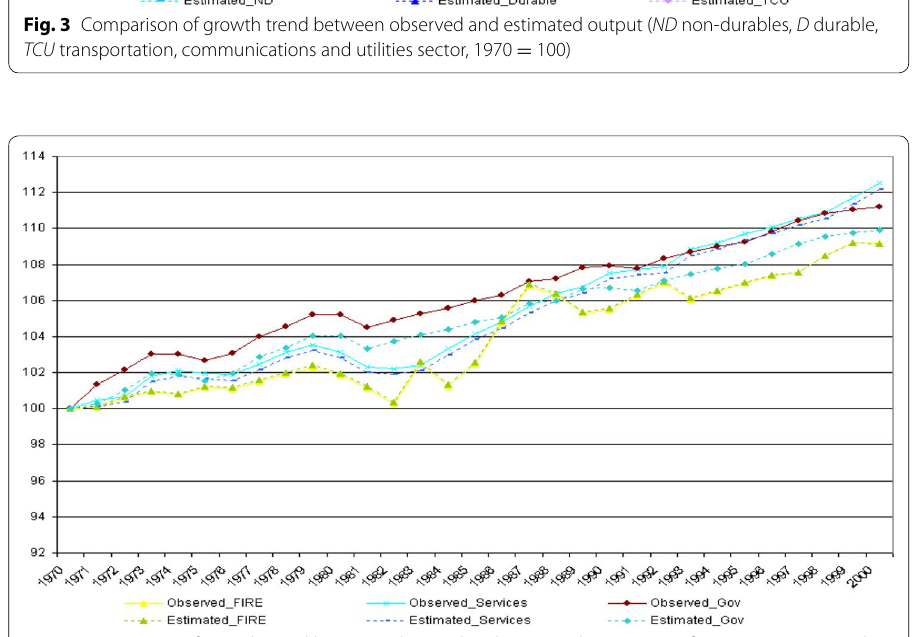
Fig. 4 Comparison of growth trend between observed and estimated output ( FIRE finance, insurance and real estate, services, government sector, 1970